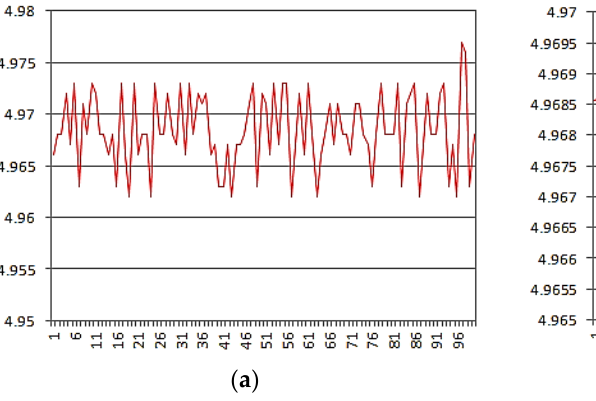
Figure 11. Verification experiment.